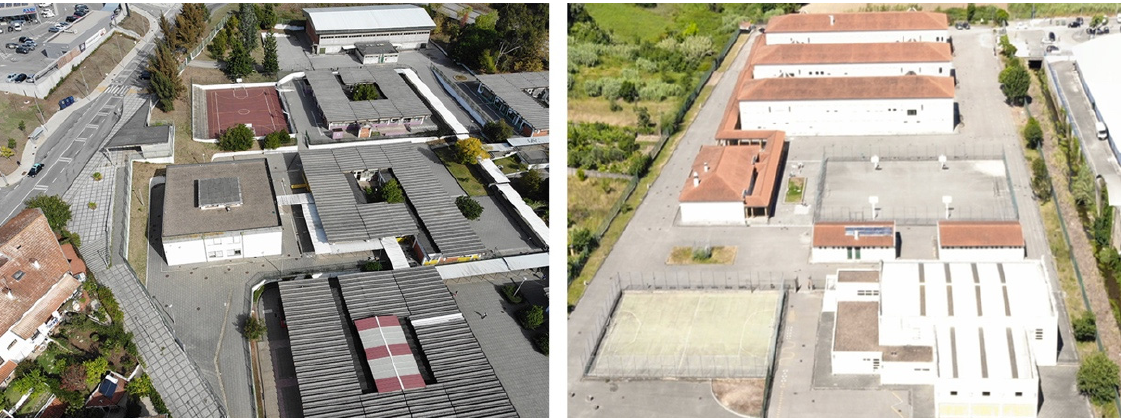
Figure 5. Drone images from CoReD partner schools — Escola Básica Eugénio de Castro (EBEC) ( left ), Escola Básica Rainha Santa Isabel (EBRS) ( right ). Escola B á sica Rainha Santa Isabel (EBRS) ( right